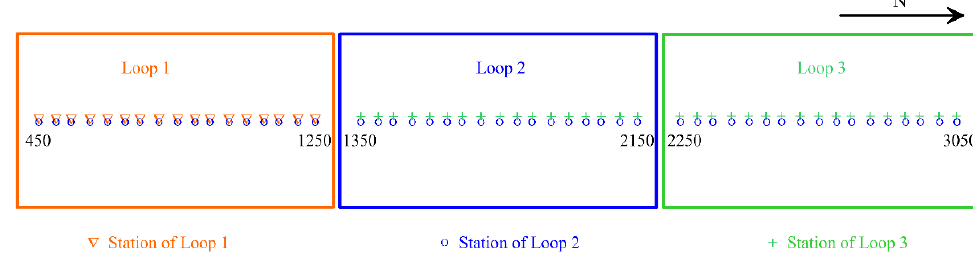
Table 5. Parameters of field data collection.